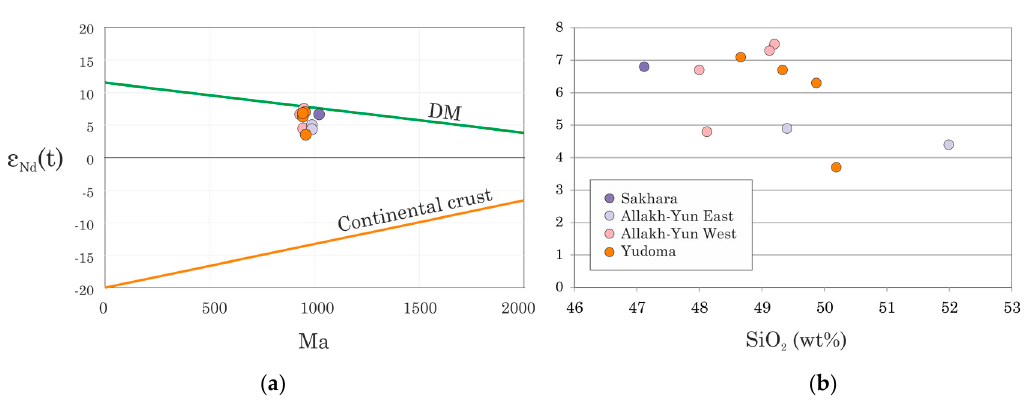
Figure 7. ( a ) ε Nd(t)—age (Ma) plot. ( b ) ε Nd(t)—SiO 2 (wt%) plot.